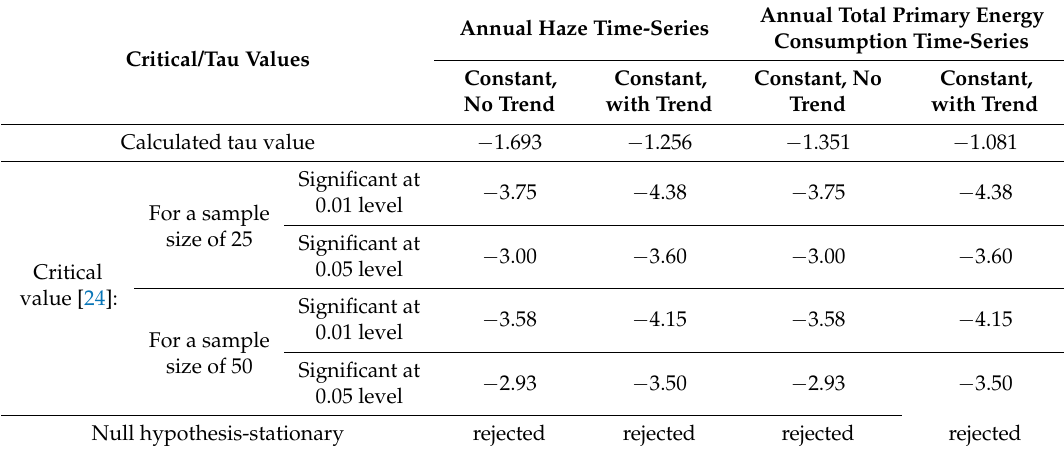
Table 2. Results of Dickey-Fuller tests.